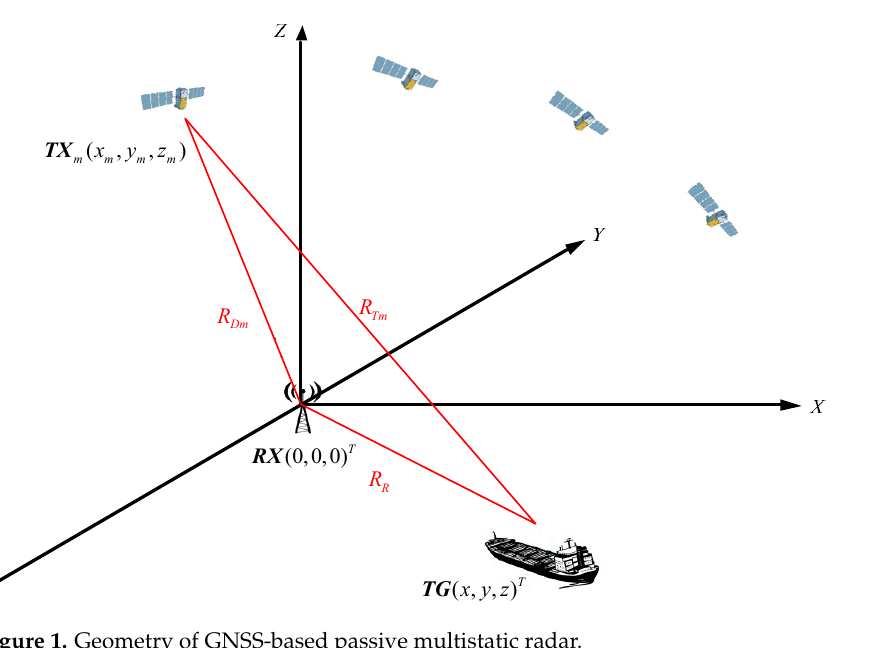
Figure 1. Geometry of GNSS-based passive multistatic radar.